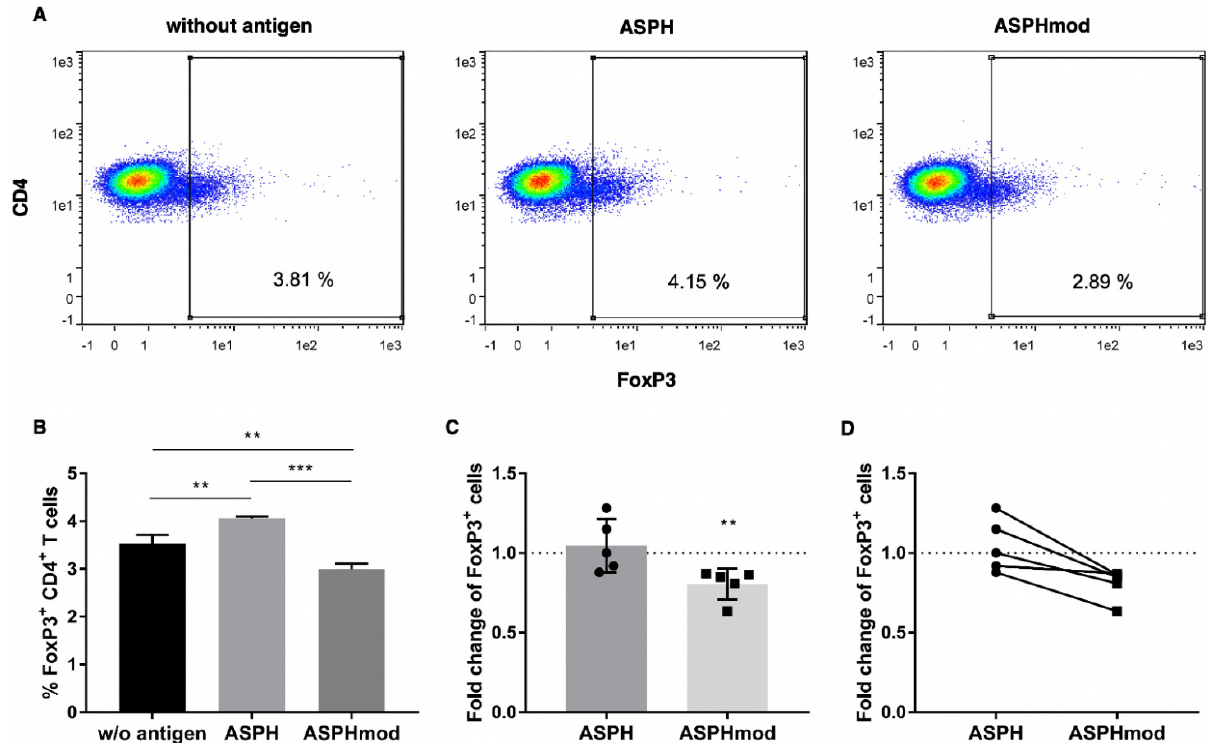
Figure 7. ASPHmod-pulsed moDCs induce fewer T reg cells. ( A ) Representative flow cytometric analysis of a single individual. ( B ) Number of CD4 + FoxP3 + T cells after restimulation with no antigen-, ASPH- or ASPHmod-pulsed DCs. Data represent the mean ± SD of a single individual donor assessed in triplicate: ** significantly different, p < 0.01, *** significantly different, p < 0.005 (one-way ANOVA). ( C ) Fold change in CD4 + FoxP3 + T cells relative to cells restimulated with the non-pulsed moDC control. Data represent the means ± SD of five individuals: ** significantly less, p < 0.01 (Mann–Whitney test). ( D ) Relative T cell response of nine individuals to ASPH- versus ASPHmod-pulsed moDCs.